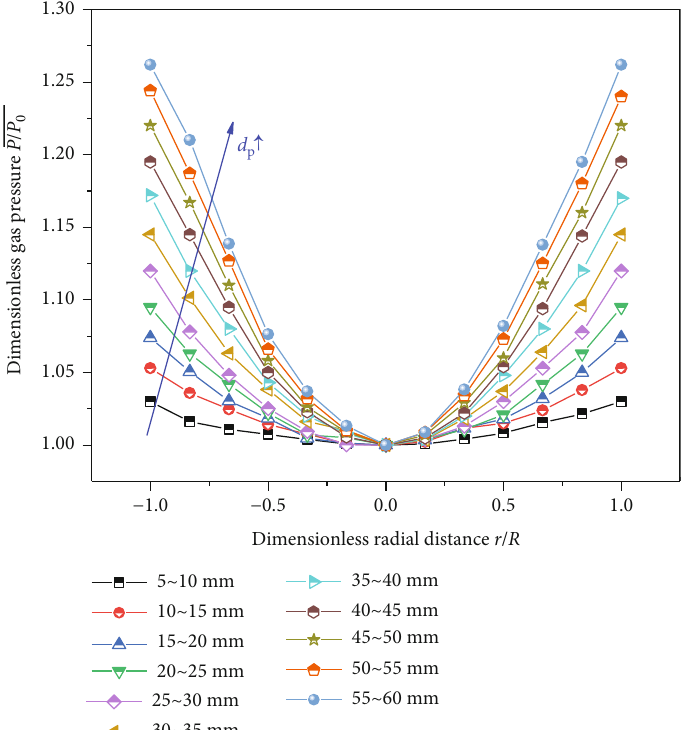
Figure 6: The radial distribution of the average dimensionless gas pressure ( P / P under 11 kinds of particle sizes.